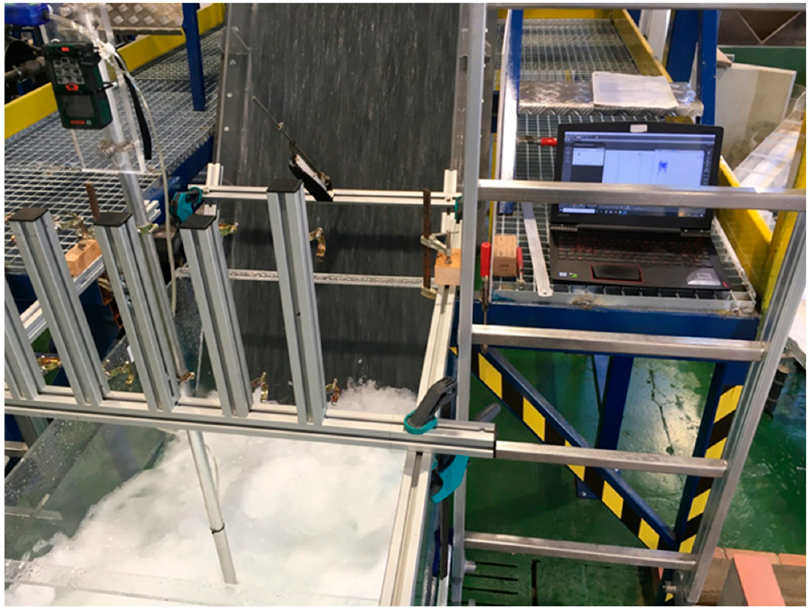
Figure 4. Pitot tube measures in the stilling basin physical model.